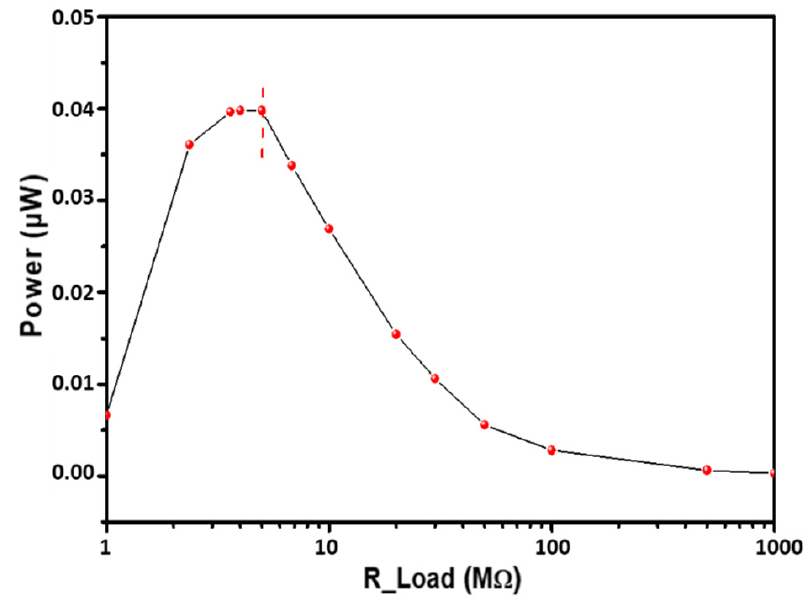
Figure 5. Estimated instantaneous power as a function of load resistance.